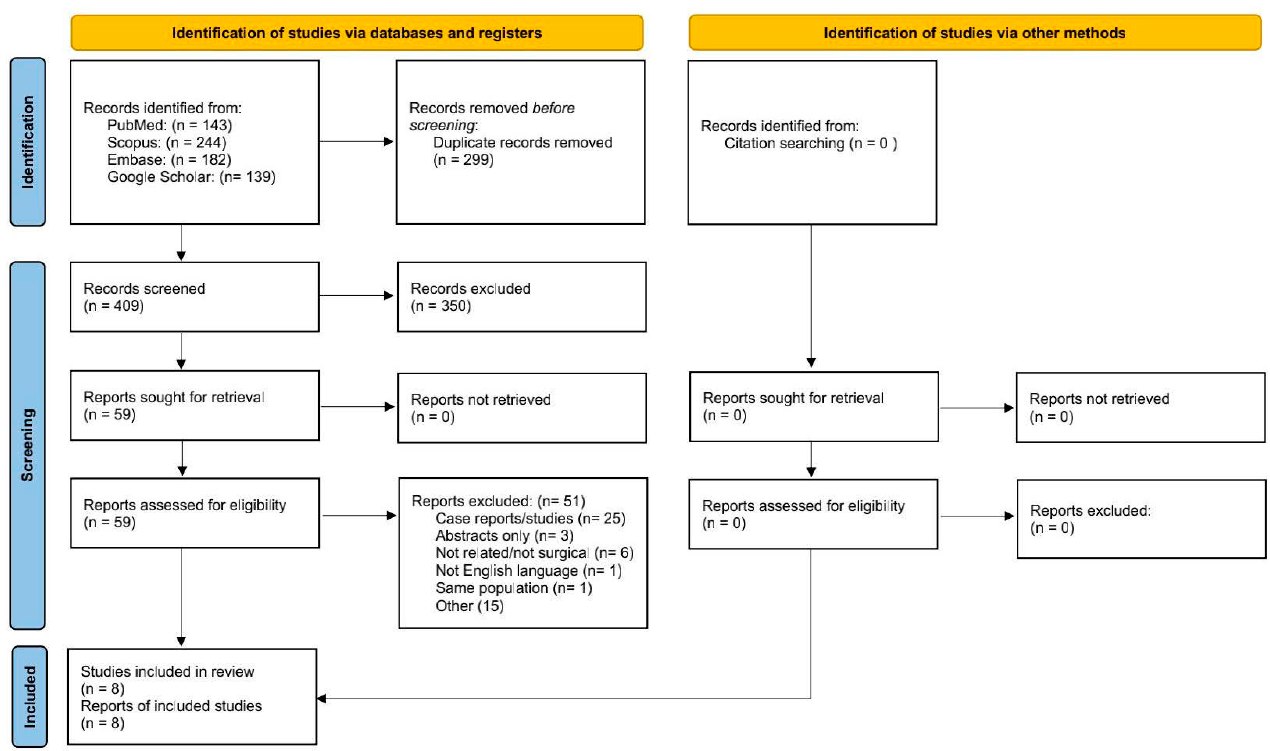
Figure 1. Flow chart of the study according to PRISMA guidelines.